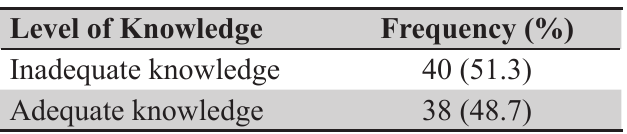
Table 1. Knowledge level of participants on